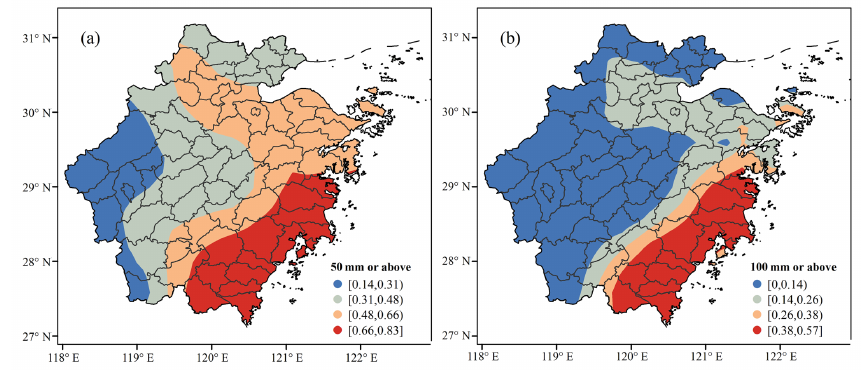
Figure 5. Probability of the occurrence of typhoon rainstorms in Zhejiang Province: (a) rainstorms with precipitation > 50mm and (b) torrential rainstorms with precipitation > 100mm.